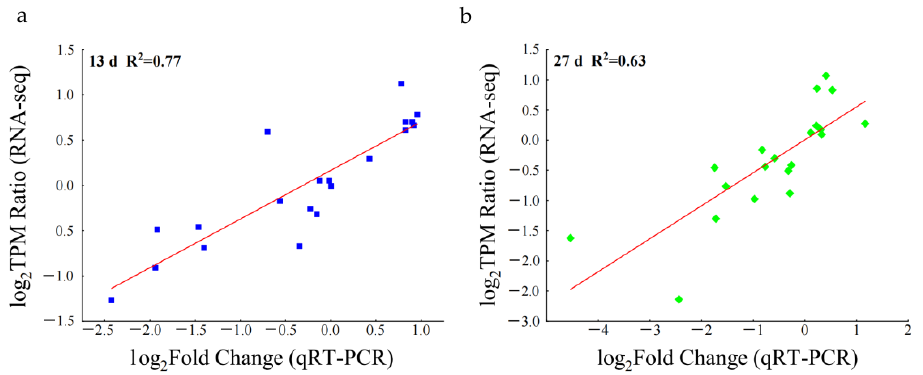
Figure 4. Correlation between RNA-seq and qRT-PCR results of samples collected at days 13 ( a ) and b 27 ( b ). X-axis denoted Log 2 (the ratio of qRT-PCR) using the method 2 − ∆∆ Ct to calculate the relative expression level. Y-axis represented the TPM values in RNA-Seq data. Each square in the figure ( a , b ) represents the amount of gene